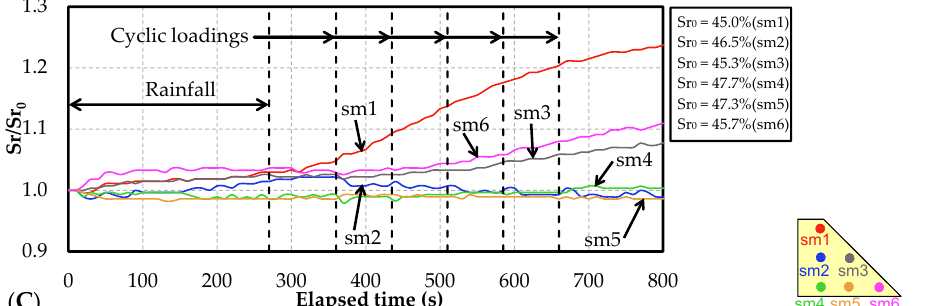
Figure 19. Changes in saturation degree during post-rainfall earthquakes tests ( A ) K 8.5A, ( B ) K soil, ( C )